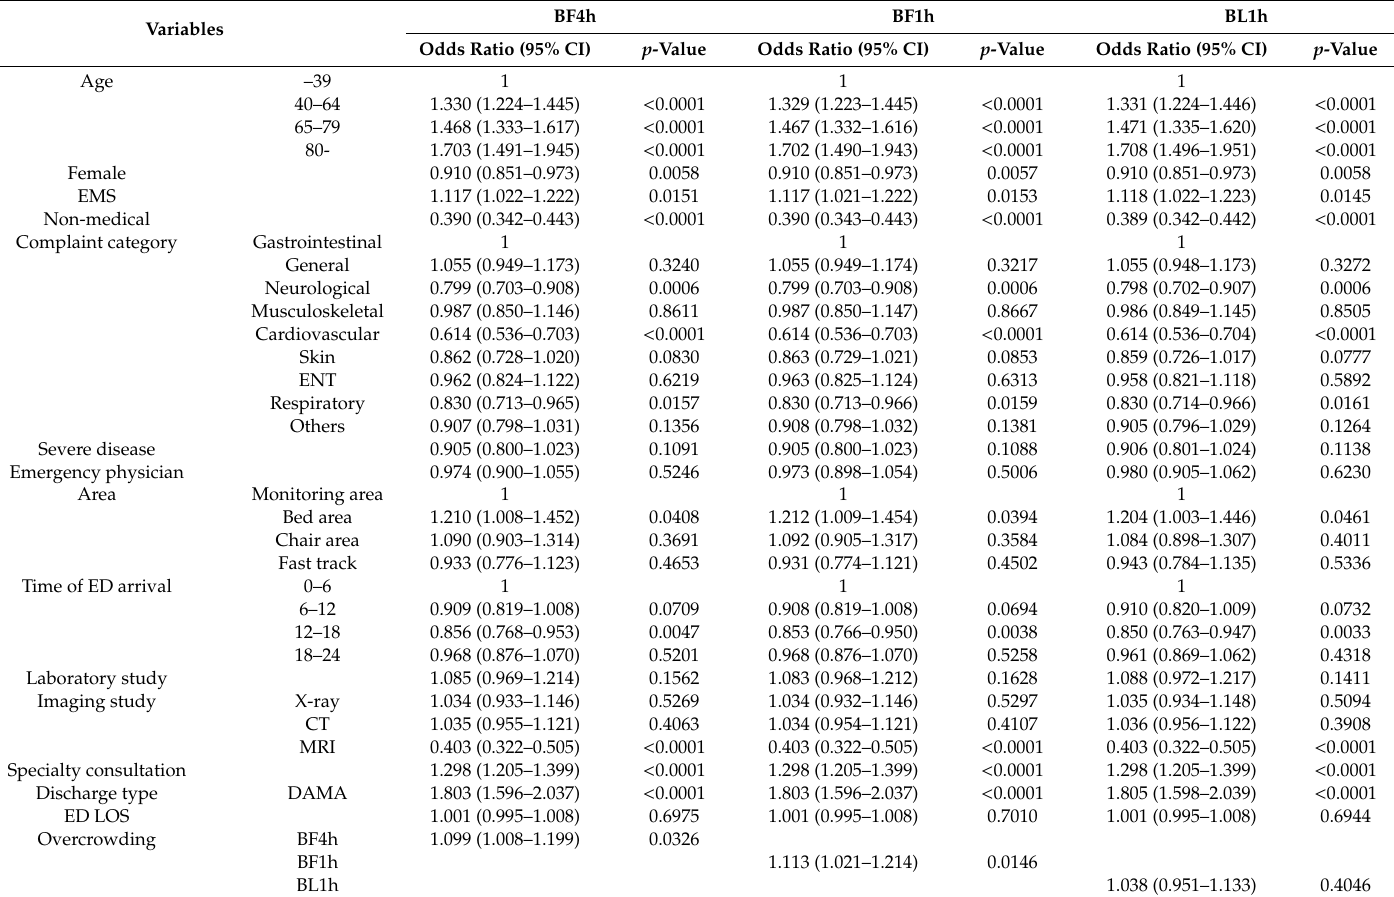
Table A4. Multivariable logistic regression of emergency department overcrowding of the number of boarding patients for return visit within 72